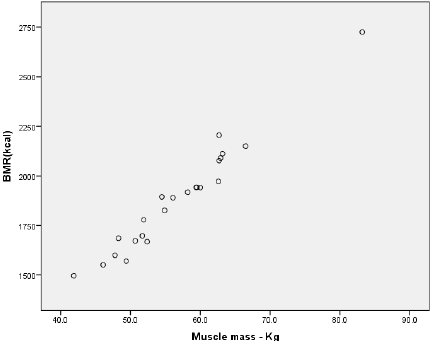
Figure 7. Correlation between BMR and muscle mass (kg) for the group of boys without ID.